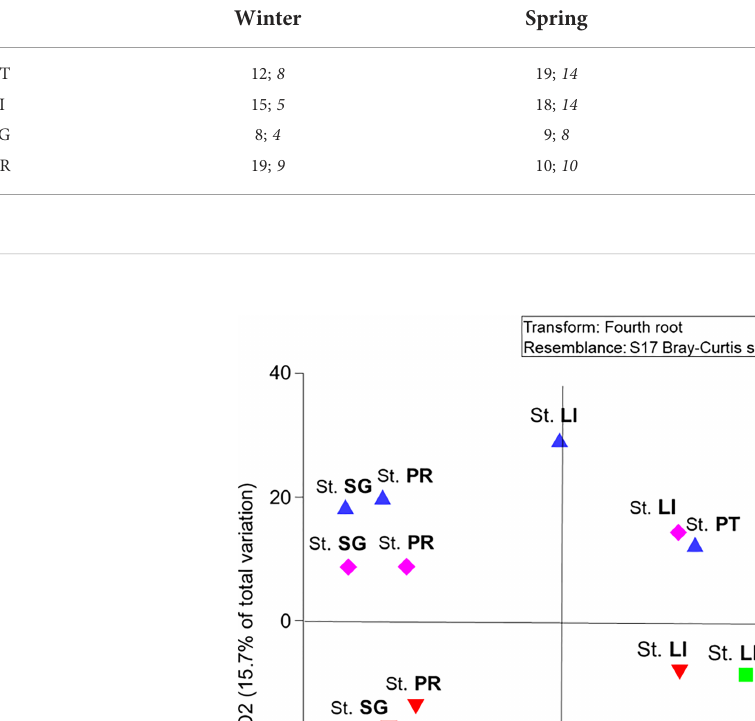
TABLE 3 Number of phytoplankton taxa that made up 90% of the total abundance and accounted for more than 2% (in italics) in each season and station; St. SG, San Giuliano station; St. PR, Palude della Rosa station; ST LI, Lido station; St. PT, Platform station.